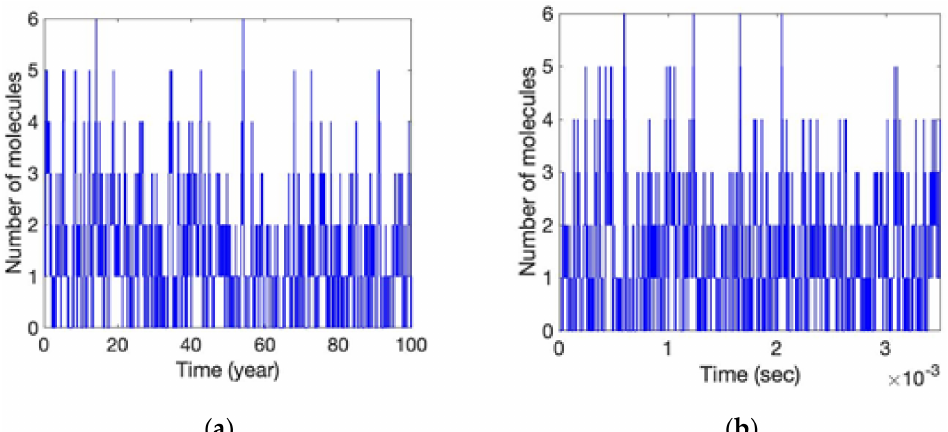
Figure 8. Simulation results of ( a ) Gillespie stochastic algorithm and ( b ) the architecture of Figure 7 for the reactions of A β turnover. Note that the simulated reaction rates of ( b ) are scaled up by 3.125 × 10 9 than the actual biochemical reaction